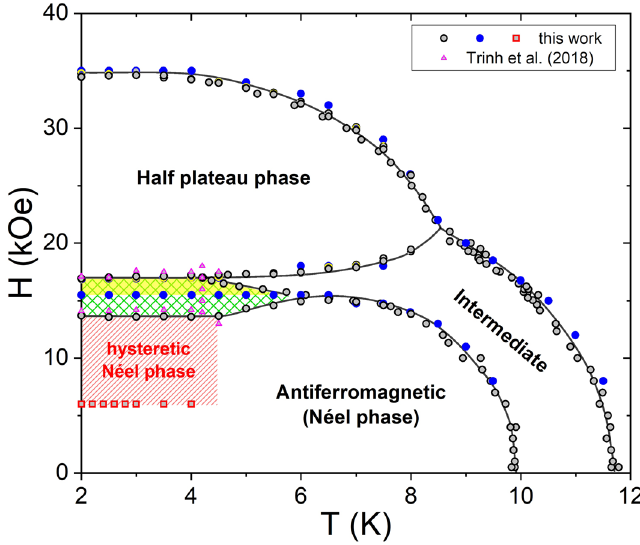
Figure 4. Phase diagram of TmB 4 showing the part with stable fractional plateaus (sFP), yellow area above the blue points, and the part with metastable fractional plateaus (mFP), whole hatched green area, of the FPP and the ”hysteretic” part of the AF Néel phase with ~ 1/1000 M sat magnetization jumps (red hatched area above the red points). Note that the sFP area can be reached by cooling in constant field directly from the intermediate phase. Black, blue and red points were determined from various magnetization measurements, magenta points (triangles) were taken from Ref. 37